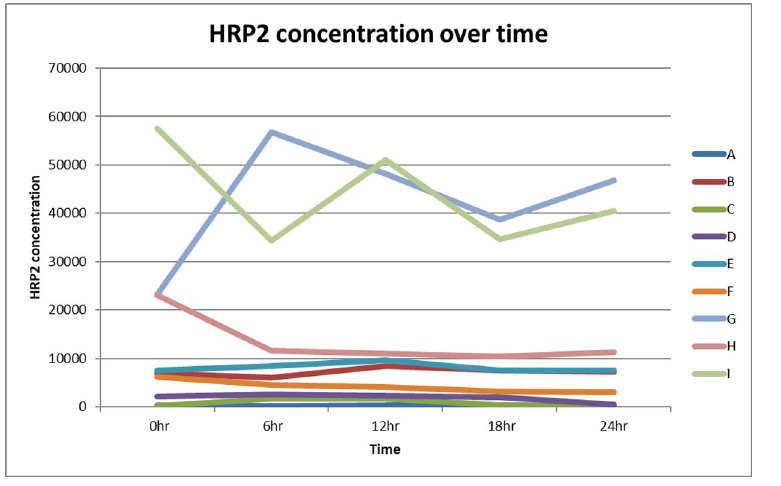
Fig 1. Histidine Rich Protein II pharmacokinetics for nine individual patients (n = 9).